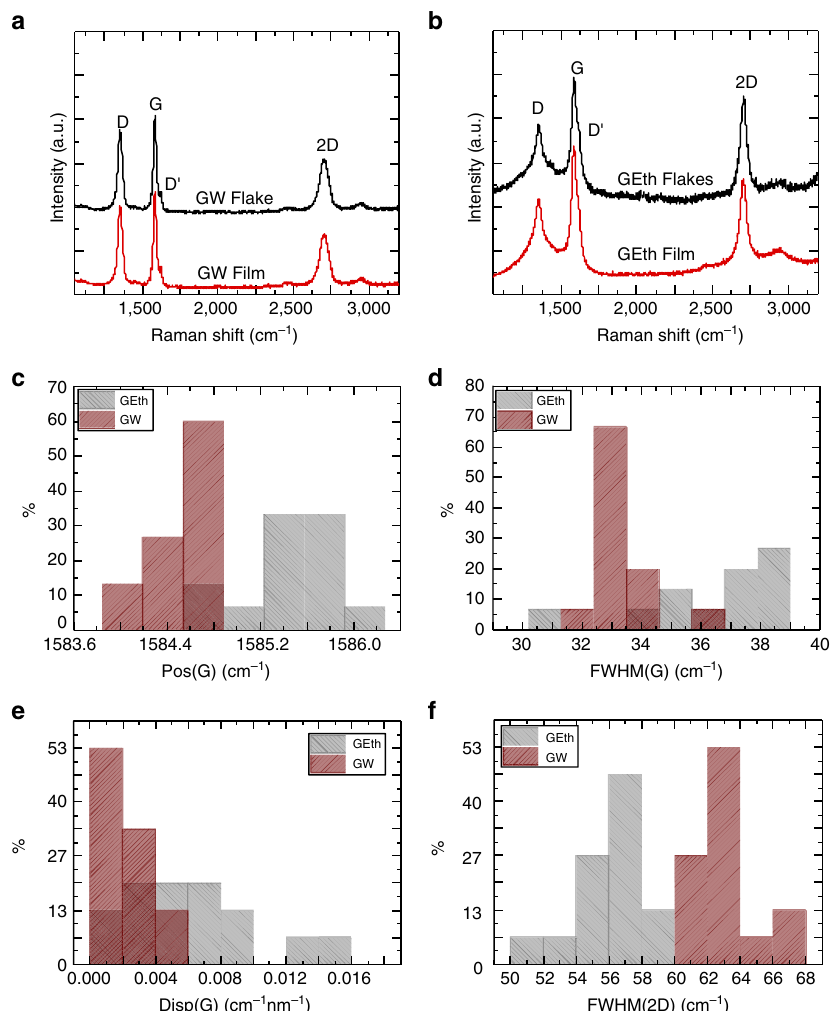
Figure 4 | Raman spectroscopy. Raman spectra acquired at 514.5nm of ( a ) GW flakes (black) and a GW film deposited on SiO 2 /Si (red) and of ( b ) GEth flakes (black) and a GEth film (red). Statistics of ( c ) Pos(G), ( d ) FWHM(G), ( e ) Disp(G) and ( f ) FWHM(2D) for GEth (grey) and GW (red) B 1.3 W cm (cid:2) 2 for Eth-GSA, due to the different pulsed operating regimes used for Eth-GSA.